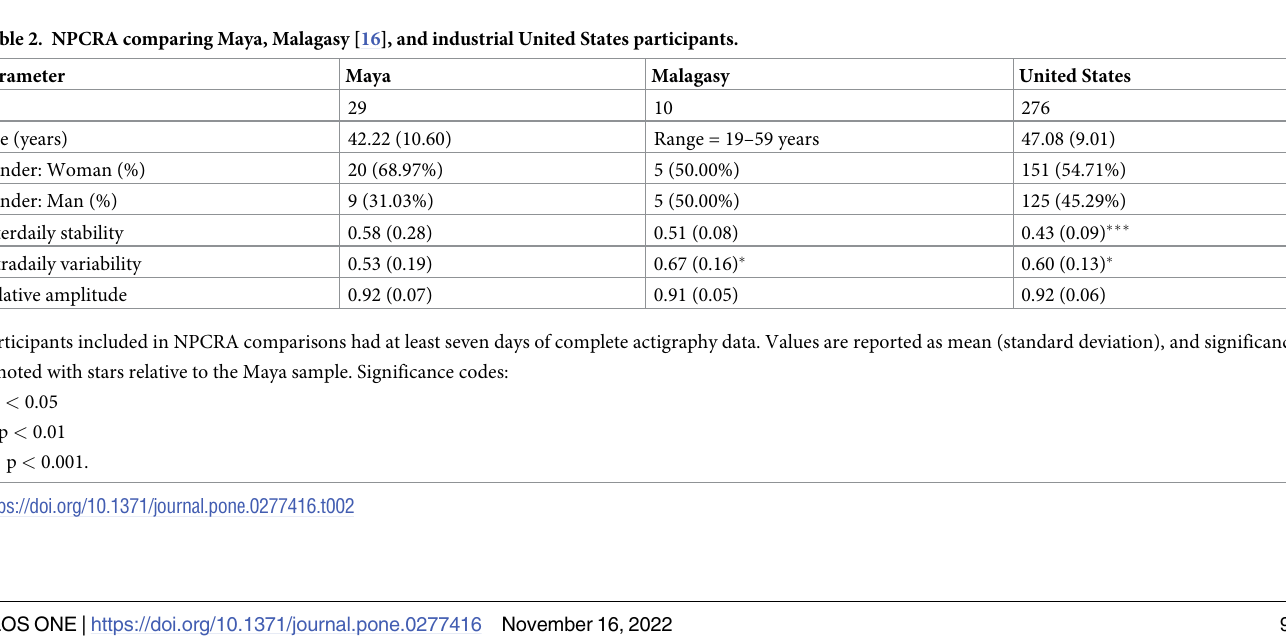
(83.26%; W = 289183, p < 0.001). WASO in the Maya participants (1.51 hours) is less than the Malagasy participants (2.10 hours; t = -2.60; p = 0.014) and greater than the United States sam- ple (0.69 hours; W = 819332; p < 0.001). Sleep fragmentation index is lower in the Maya sam- ple (31.91) compared to the Malagasy sample (45.90; t = -3.34; p = 0.002). Table 2 shows a comparison of rest-activity patterns between Maya, Malagasy, and United States participants. Maya participants have significantly higher interdaily stability (0.58; W = 6111, p < 0.001) than the United States sample (0.43), and lower intradaily variability (0.53) than both Malagasy (0.67; t = -2.23, p = 0.038) and United States (0.60; W = 3080, p = 0.041) participants. There is no difference in relative amplitude between the three samples. We further controlled for age and gender in supplementary analyses using linear mixed effects models for sleep variables and linear regression models for rest-activity variables between the Maya and MIDUS samples. After including age and gender as covariates in our